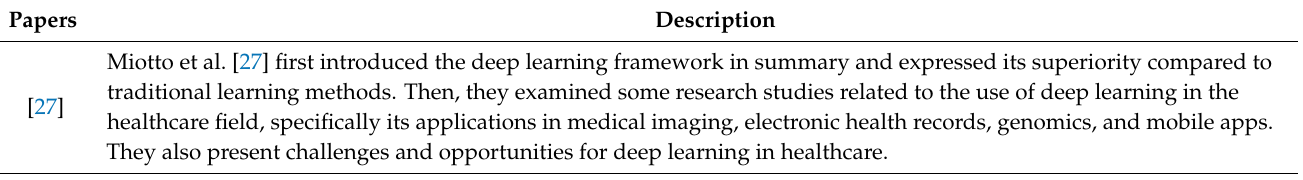
Table 1. Some review papers on ML applications in